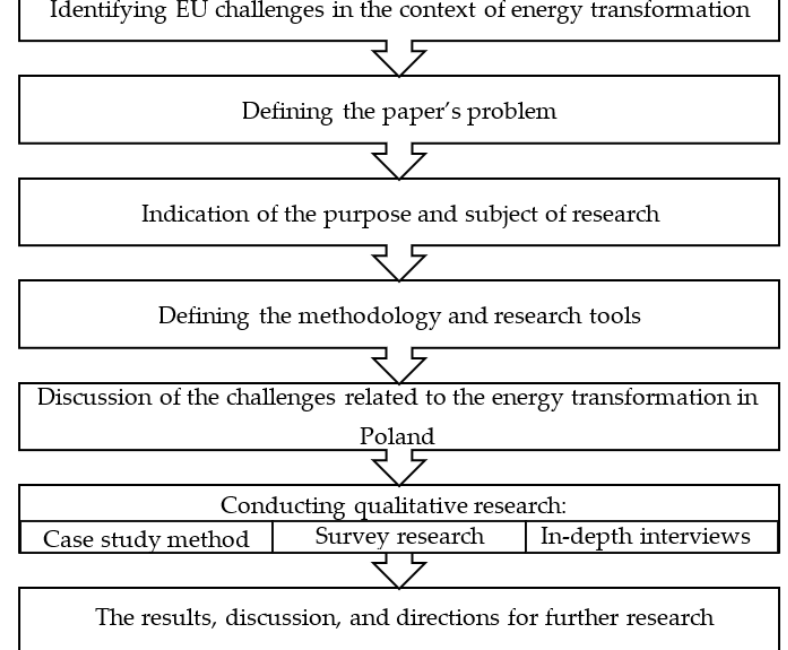
Figure 1. Stages of the research process (source: own elaboration).